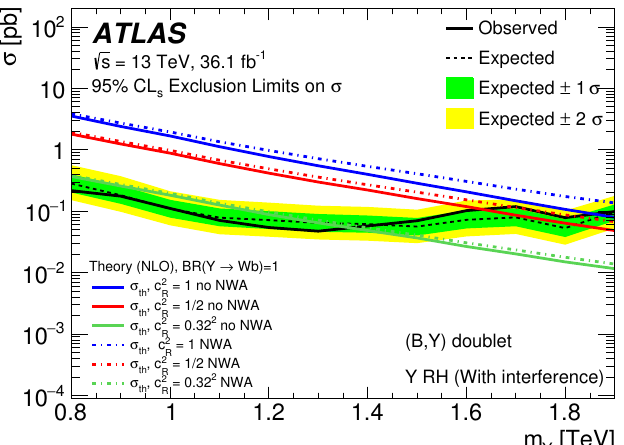
Figure 9. Observed (solid line) and expected (short-dashed line) 95% CL limits on cross-section times branching ratio for the case of the right-handed Y quark for a ( B; Y ) doublet model as a function of VLQ mass. For the theoretical prediction, the branching ratio The theoretical NLO cross-sections for di(cid:11)erent coupling values are shown for the calculation using the narrow-width approximation (dashed-dotted lines) and using no narrow-width approximation (solid lines) as described in the